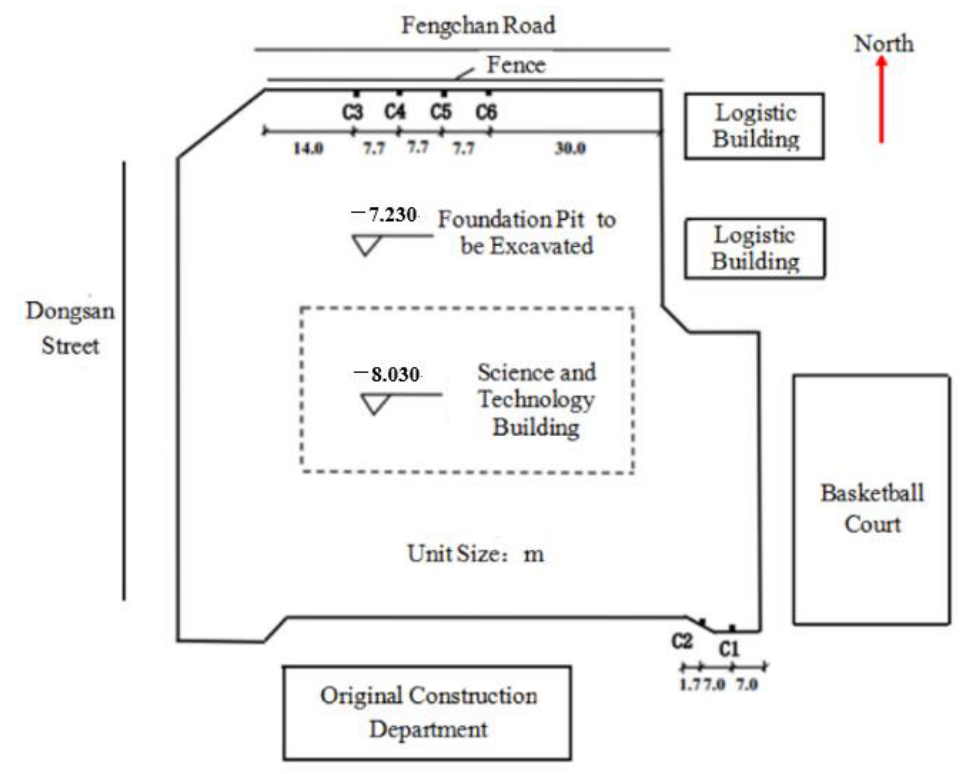
Figure 1. The plan of the foundation pit.